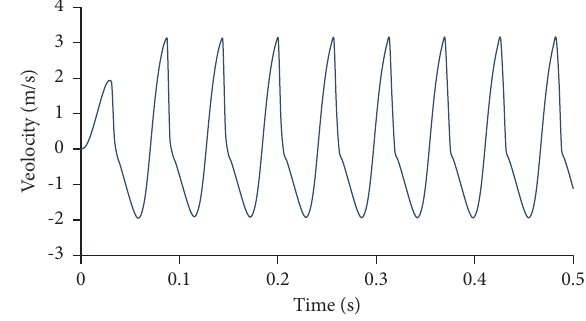
Figure 5: Velocity curve of impact piston.